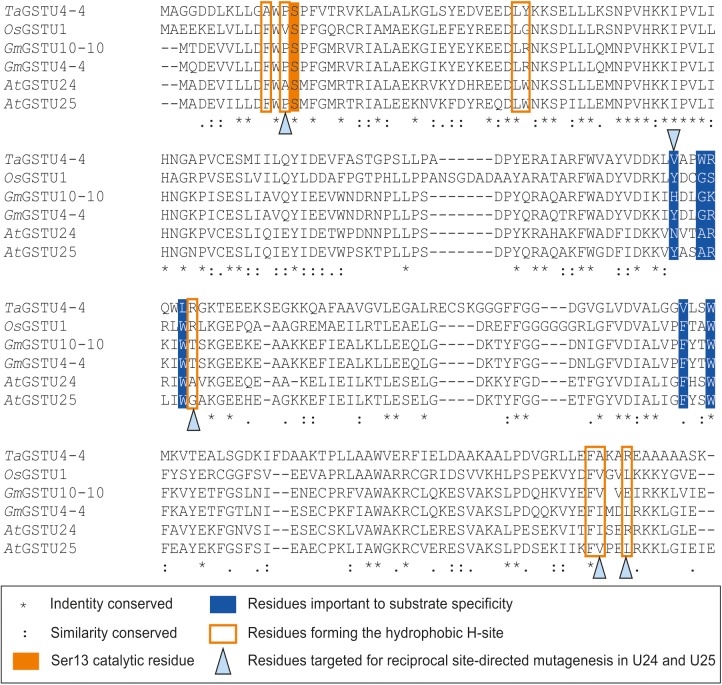
Multiple sequence alignment of Tau class GSTs. Figure generated using Clustal Omega (Sievers et al., 2011).